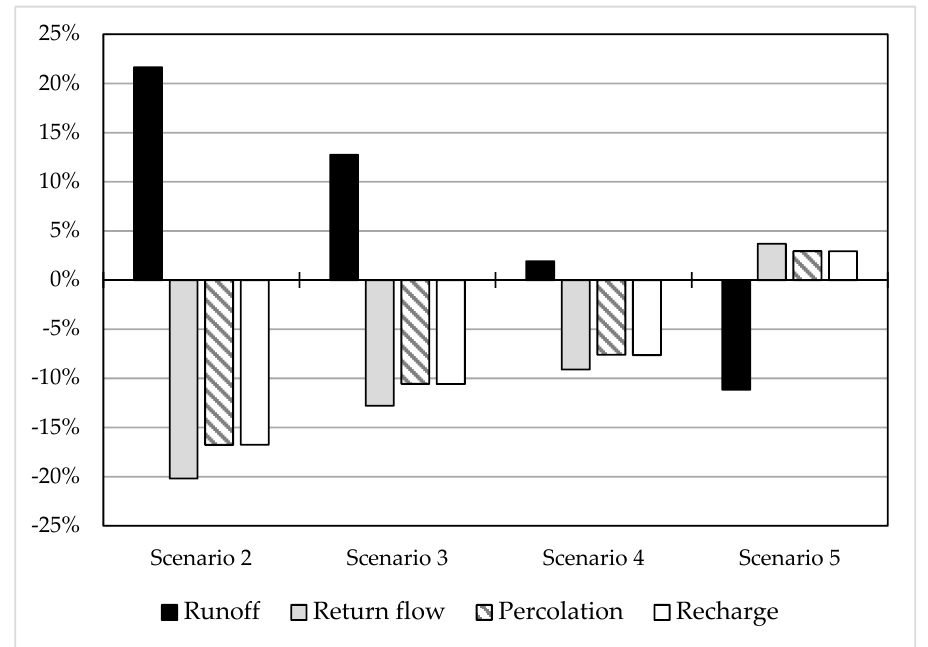
Figure 7. Relative changes in flow partitioning for Scenarios 2–5.